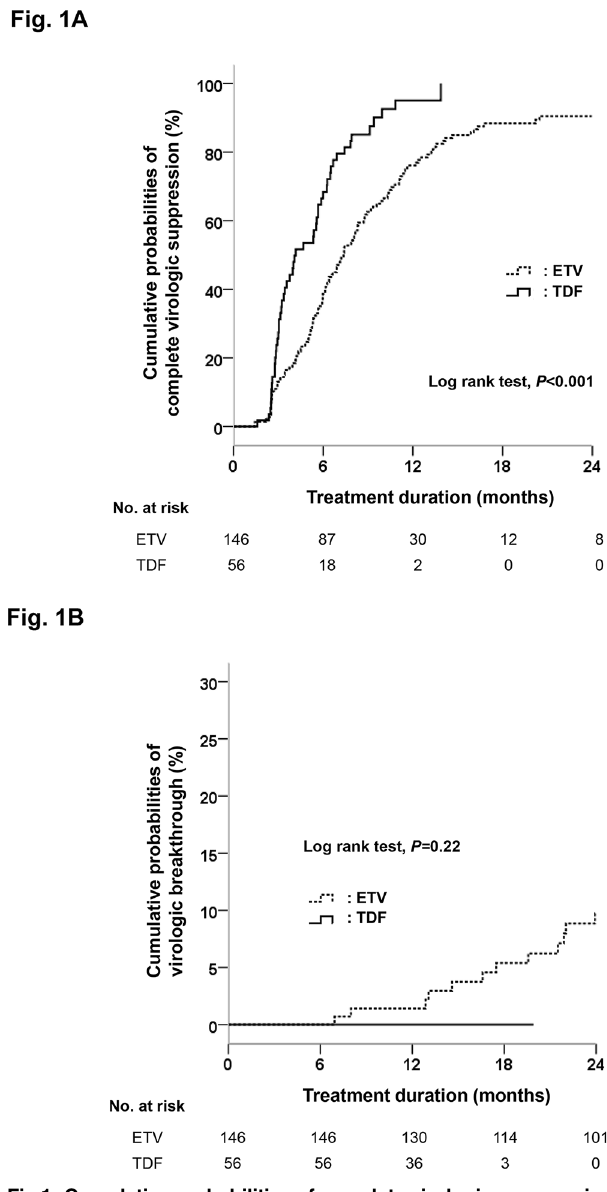
Fig 1. Cumulative probabilities of complete virologic suppression and virologic breakthrough by treatment group. (A) Cumulative probabilities of complete virologic suppression (defined as HBV DNA level < 20 IU/mL) during the treatment period are shown for each group. (B) Cumulative probabilities of virologic breakthrough (defined as an increase in HBV DNA level > 1 log10 IU/mL) during the treatment period, are shown for each group. TDF, tenofovir disoproxil fumarate; ETV,